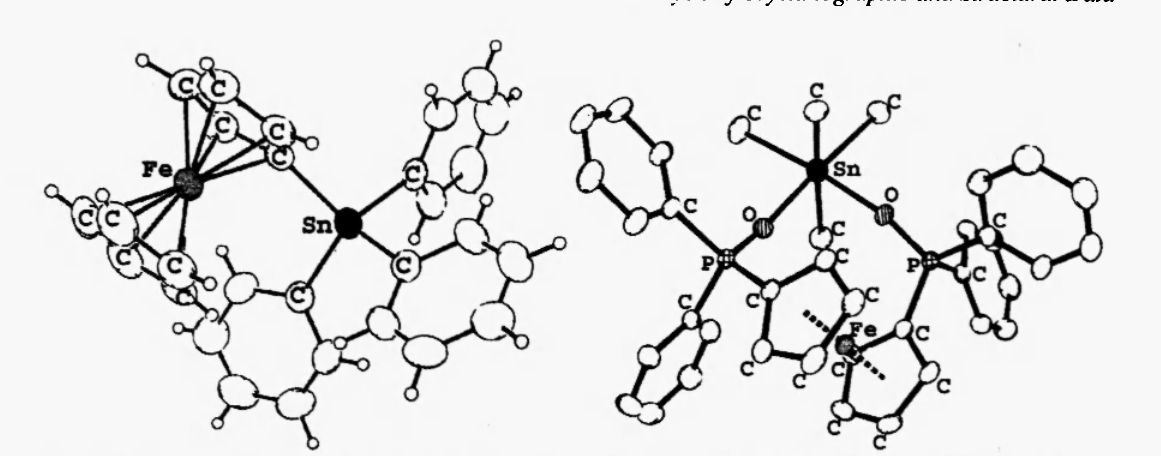
Fig. 5. Structure of PhjSninrCjHOFecp [134] Fig. 6. Structure of [CL,Sn^-OP(Ph 2 XCsH4)} 2 Fel